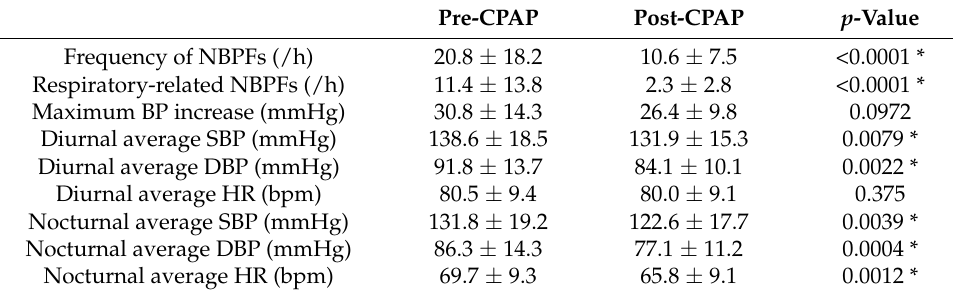
Table 2. Changes in nocturnal BP fluctuations, BP, and heart rate.